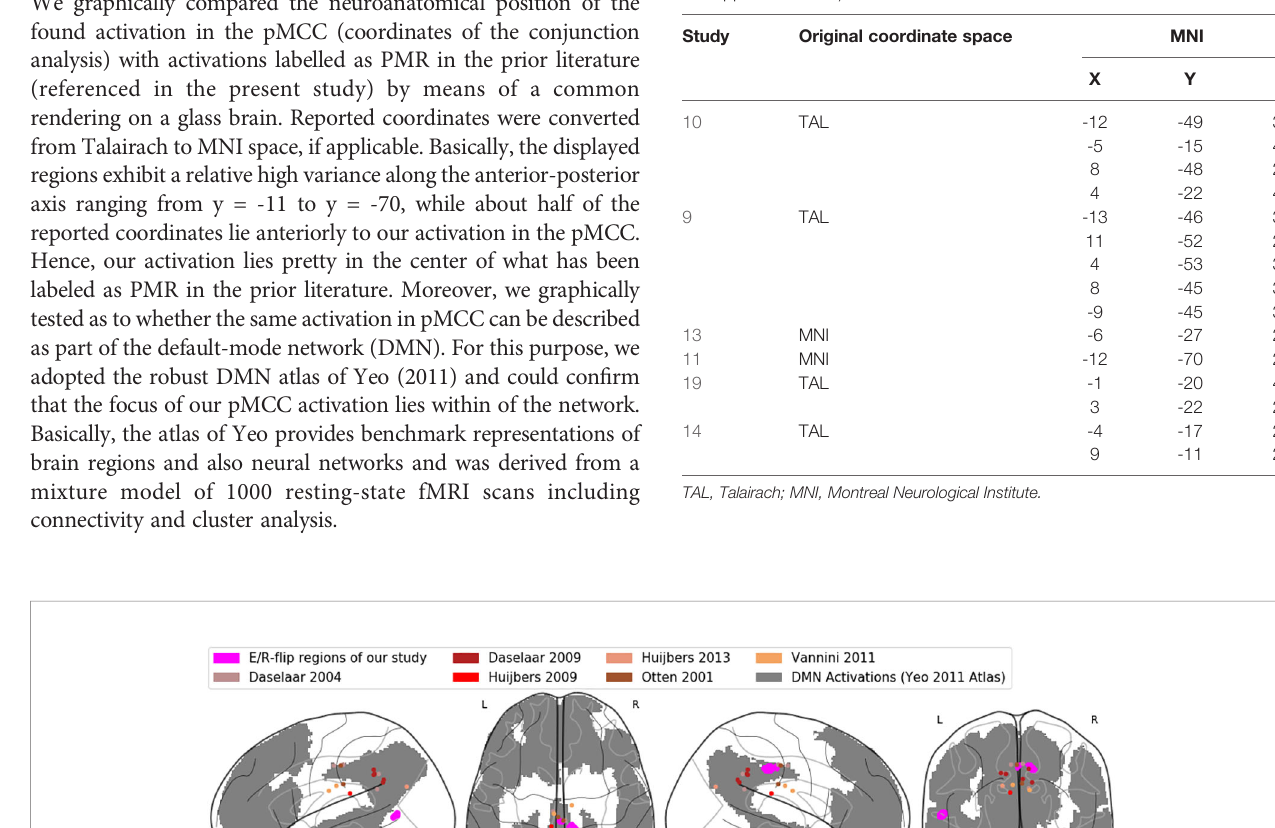
TABLE A-1 | Activations labelled as PMR in the prior literature. TAL converted to MNI using the Yale BioImage Suite Package (https://bioimagesuiteweb.github.io/